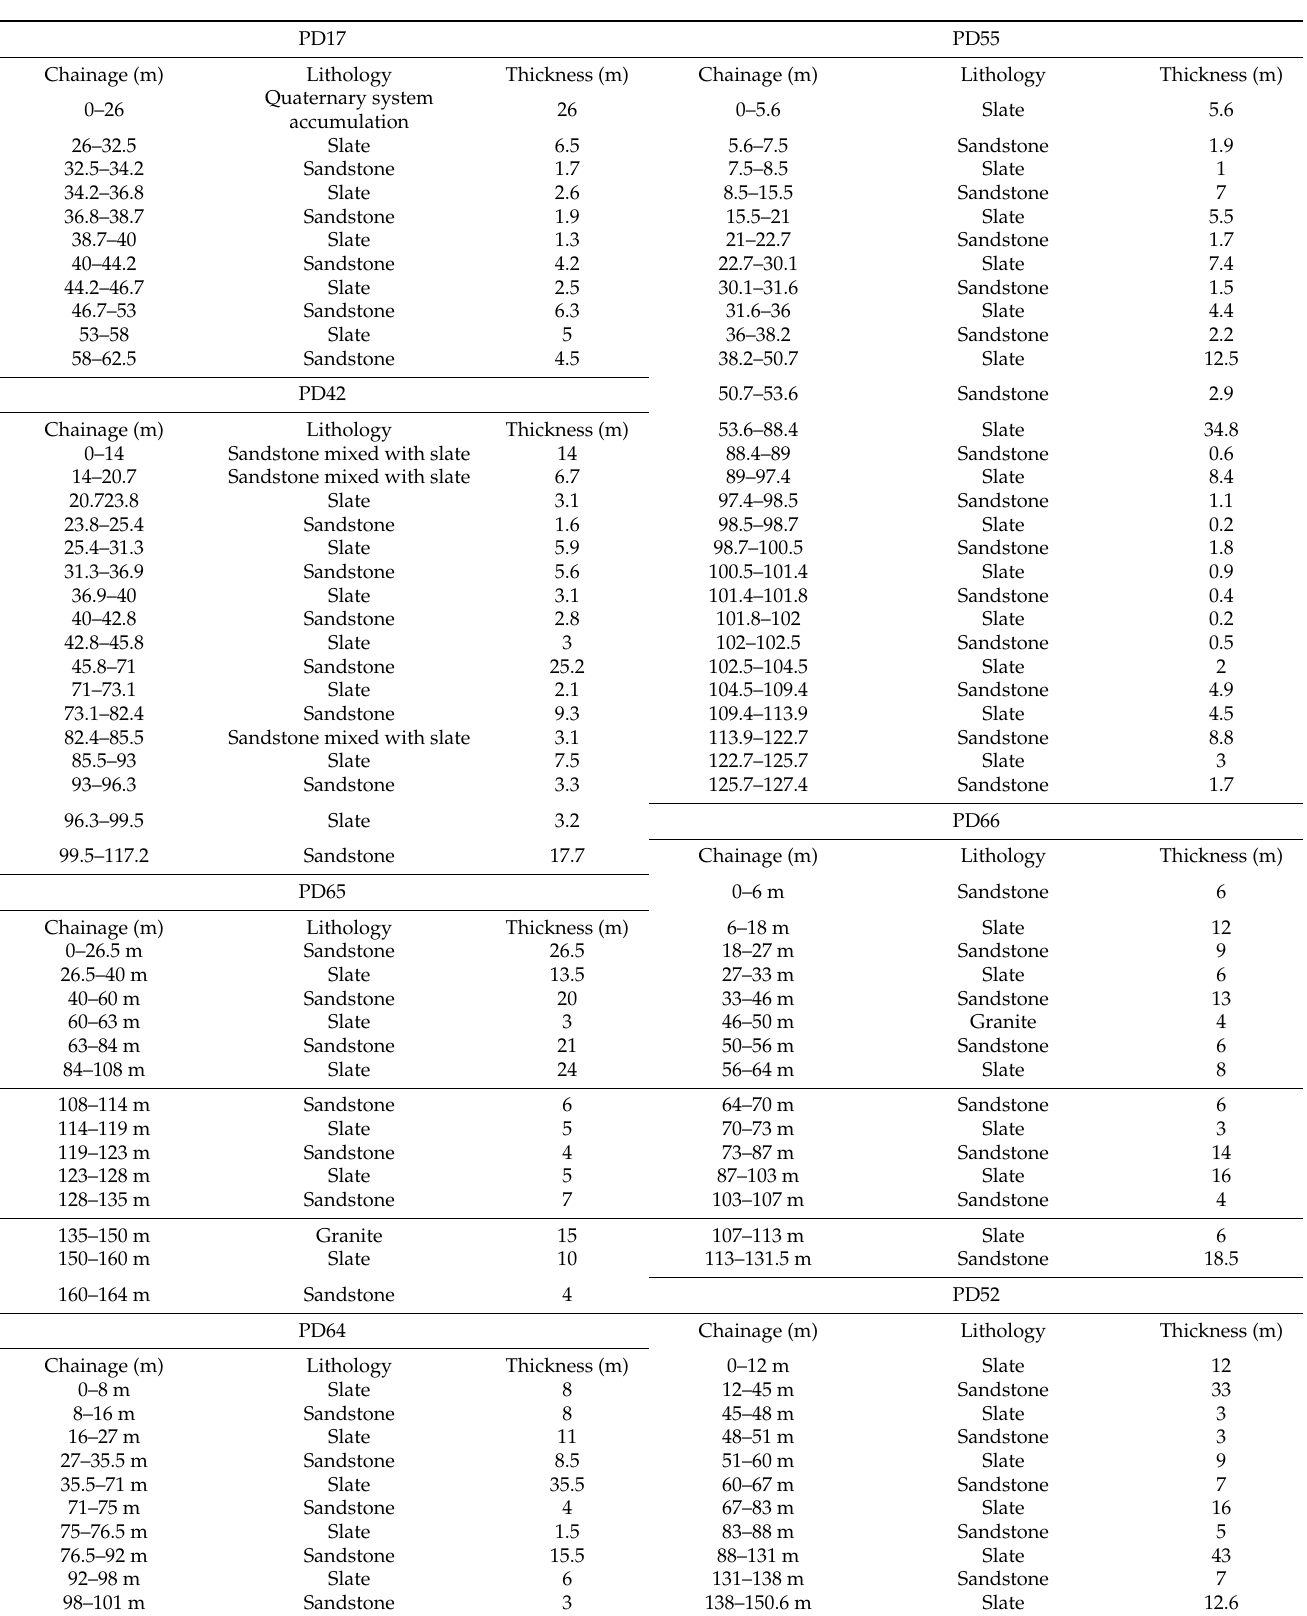
Table 1. Summary of lithological distribution of the